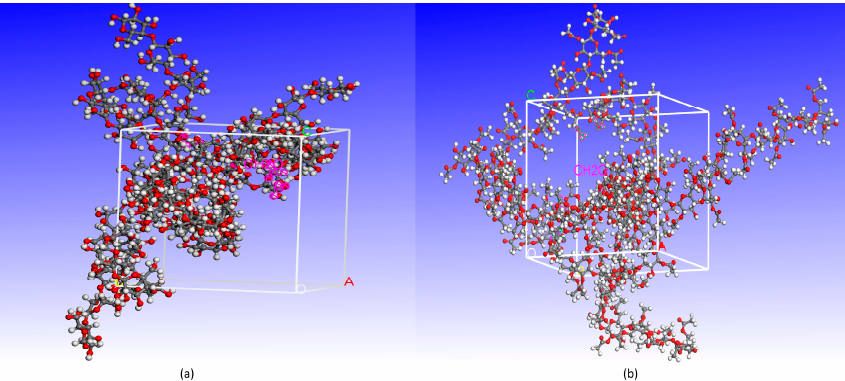
Figure 1. The c omposite model: ( a ) cellulose–formaldehyde model ; ( b ) cellulose–acetate–formal- Figure 1. The composite model: ( a ) cellulose–formaldehyde model; ( b ) cellulose–acetate– dehyde model formaldehyde